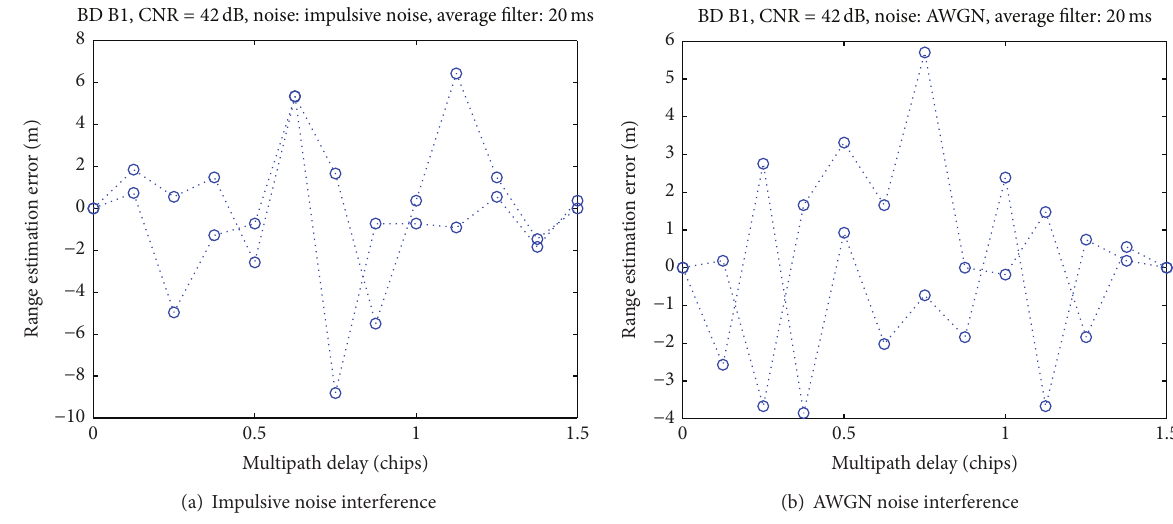
Figure 13: The ranging estimation error after removing